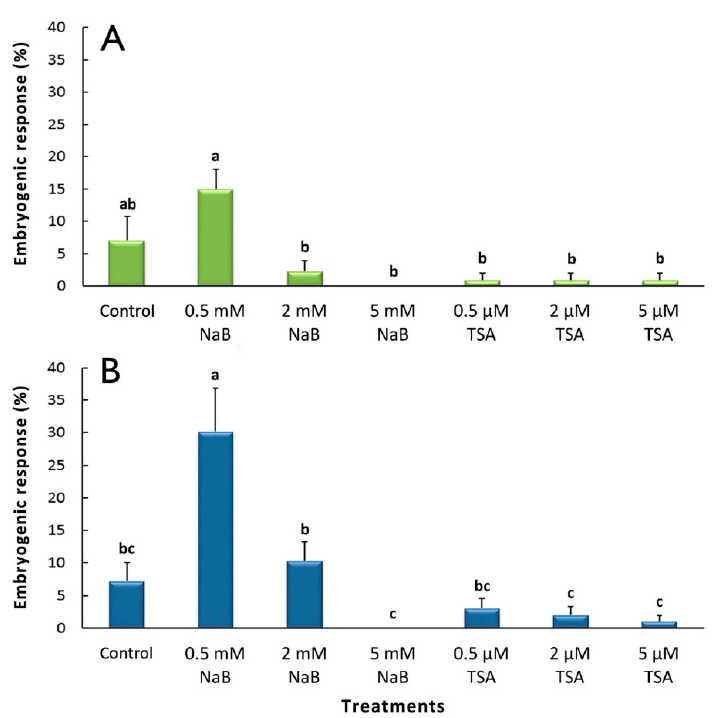
Figure 3. Effect of HDAC inhibitors (NaB and TSA) on embryogenic responses in grapevine cv. Mencía cotyledonary somatic embryos. The percentage of explants with an embryogenic response (mean ± standard error) after ( A ) 4 and ( B ) 8 weeks of culture is shown. Different letters indicate statistically significant differences ( p < 0.05).